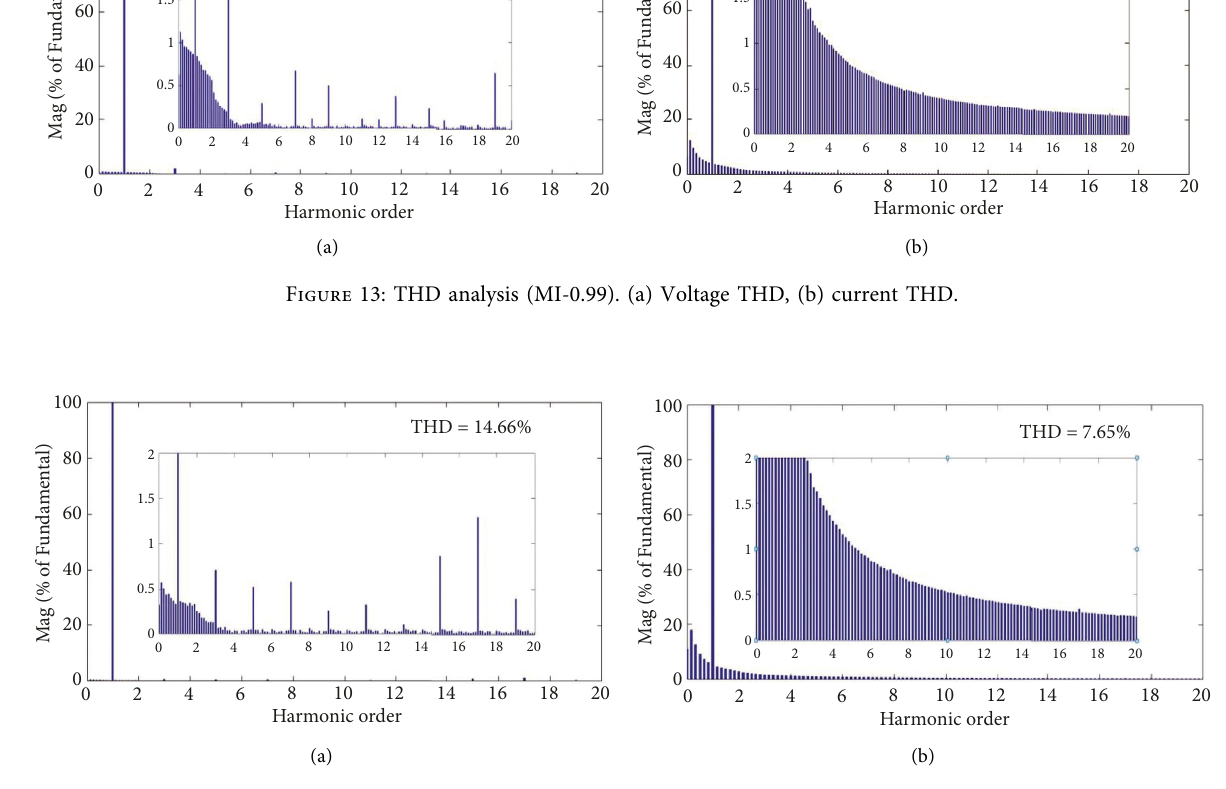
Figure 14: THD analysis (MI-0.7). (a) Voltage THD, (b) current THD.